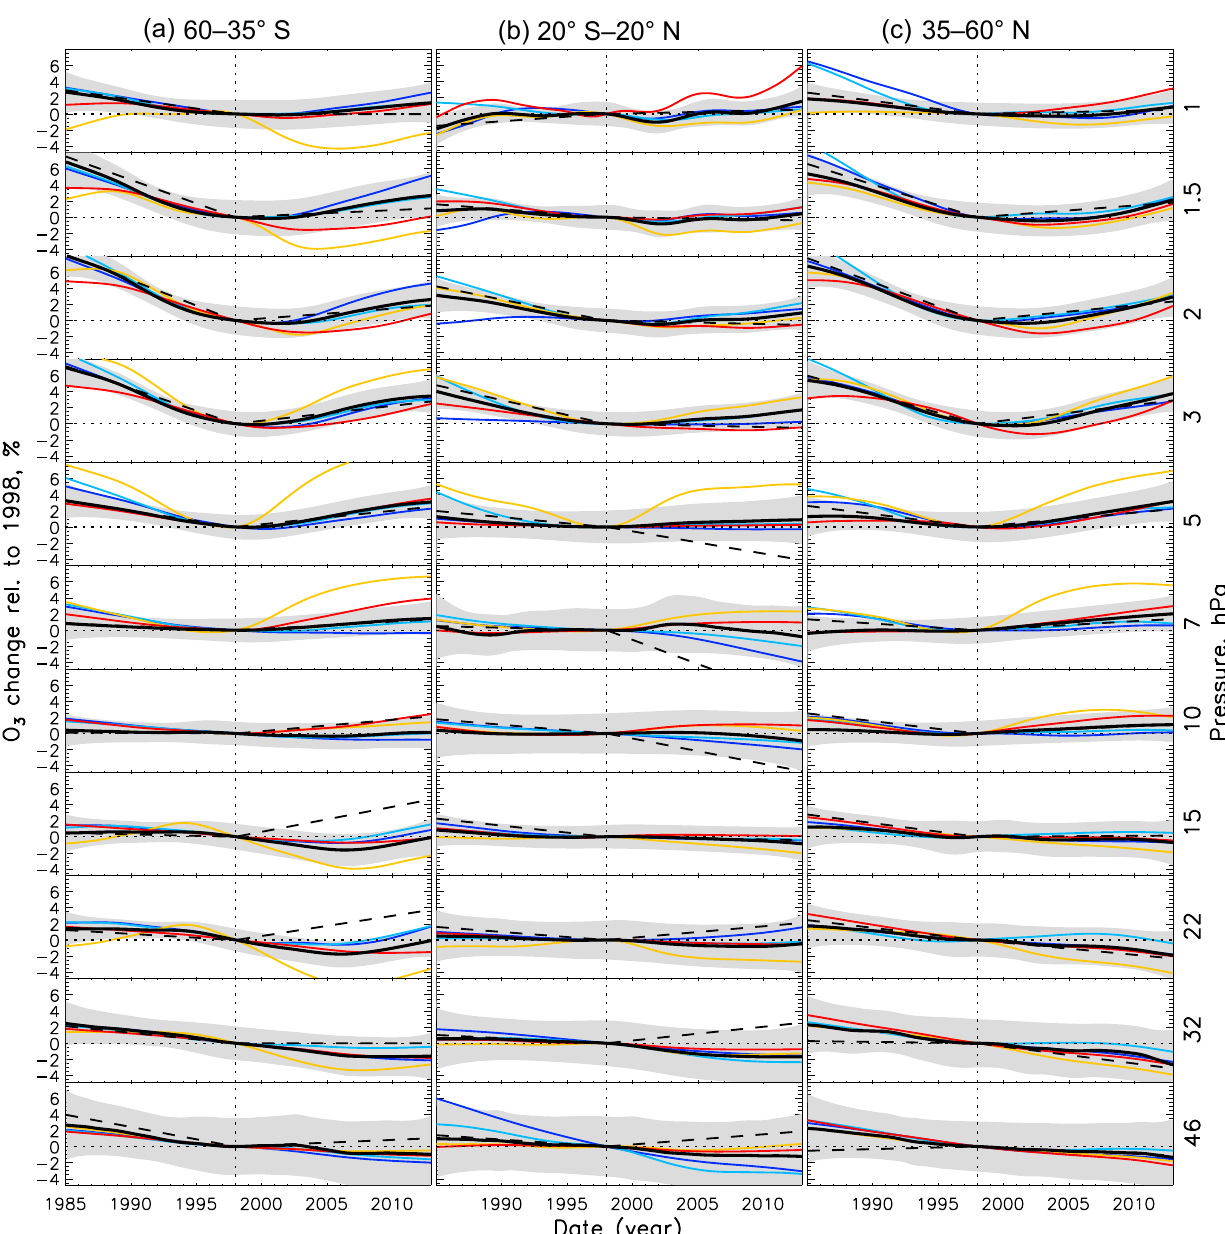
Figure 9. The percentage change in ozone (left axis) relative to 1998 (vertical dashed line; horizontal zero line) for the integrated latitude bands 60–35 ◦ S (a) , 20 ◦ S–20 ◦ N (b) , and 35–60 ◦ N (c) and pressure levels from 1hPa (top; right axis) to 46hPa (bottom). Only the mean trend lines are shown for GOZCARDS, SWOOSH, SBUV-MER, and SBUV-MOD; the BASIC composite is shown in black with shading representing the 95% credible interval. The MLR trend estimates for the period before and after January 1998 are given as dashed black